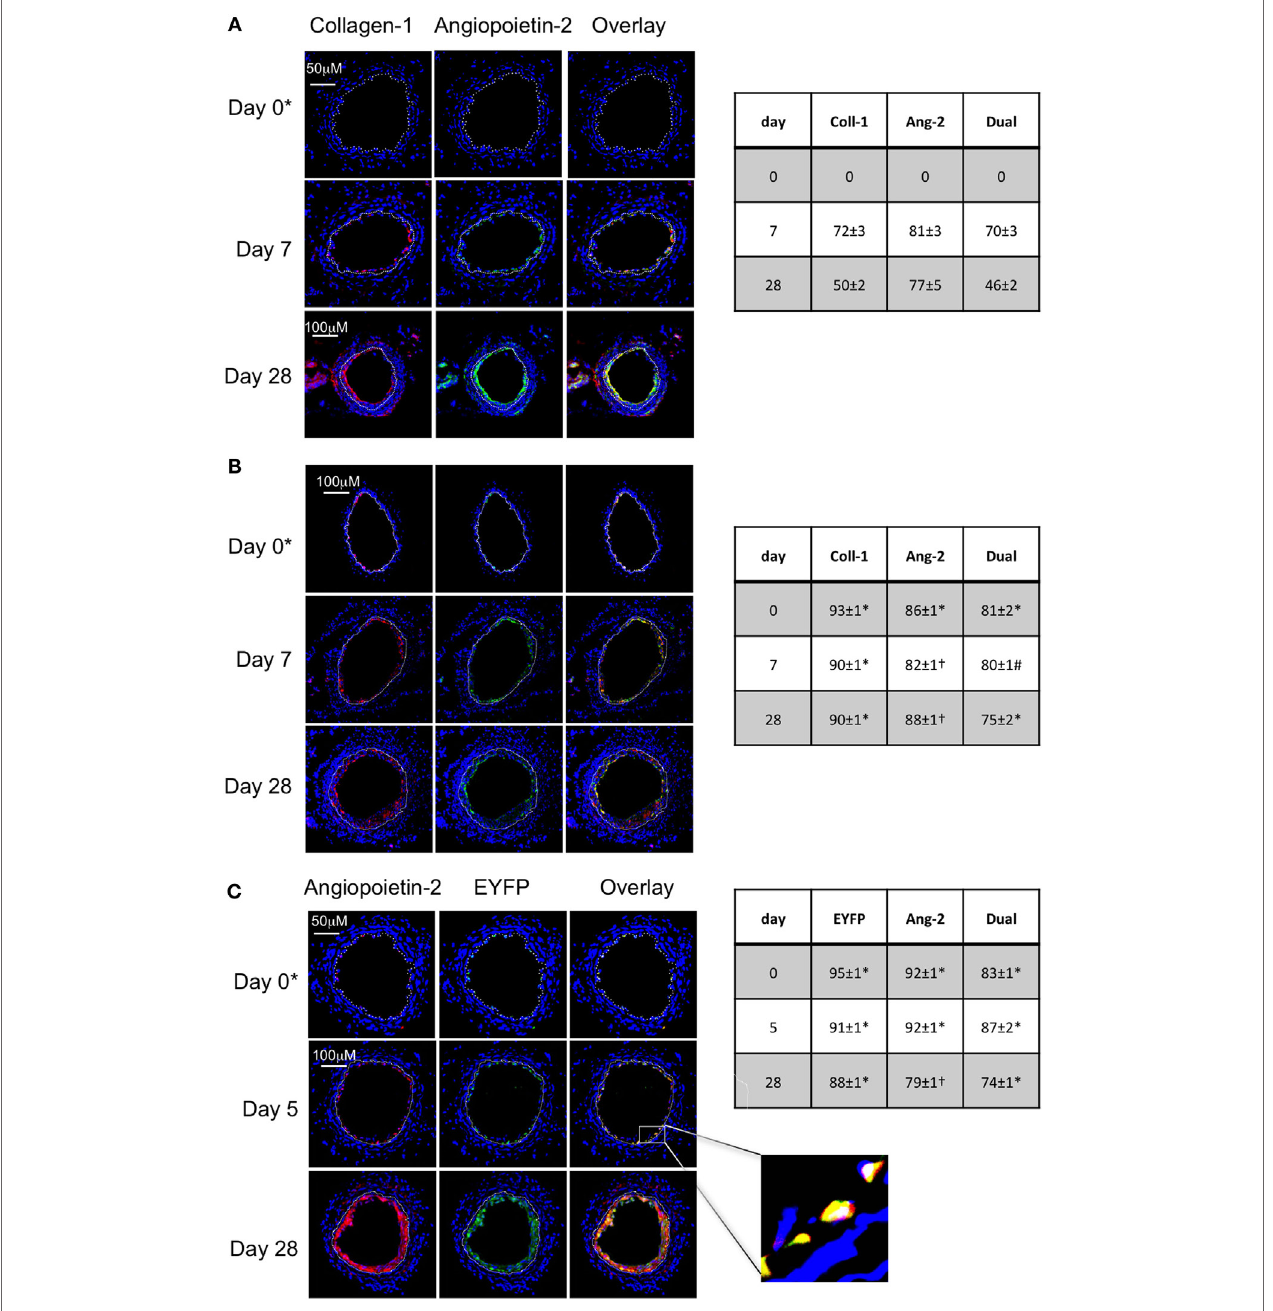
FigUre 1 | Comparison of phenotype of intimal hyperplasia in wild-type (WT) animals vs. WT after adoptive transfer of WT CD34 + cells immediately post-injury. Panels show immunohistology of representative sections through injured mouse carotid arteries harvested on days post-injury as indicated. All sections stained with DAPI (4,6 diamidino-2-phenylindole) nuclear stain (blue) and (red) anti-collagen-1 (a,B) , or angiopoietin-2 (c) , and (green) anti-angiopoietin-2 (a,B) . Yellow indicates co-localization. In (c) , the adoptively transferred cells came from enhanced yellow fluorescent protein (EYFP) mice, which spontaneously fluoresce as shown. The annotated white line defines the junction between neointima and media. (a) Injured mice received no adoptively transferred cells. *On day 0, sections harvested within an hour of injury. (B) Mice injected with cells from WT mice. (c) Mice injected with cells from EYFP mice. Expanded area illustrates that most of the early recruited cells are adoptively transferred, angiopoietin-2 + cells. Tables beside each panel describe summary of staining from all mice ( n = 6), showing the proportion of the neointimal area that is positive for collagen-1, angiopoietin-2 or both or EYFP, angiopoietin-2 or both on days 0, 5/7, and day 28 (% ± SEM). Data derived from three random sections from each of the arteries from each mouse (see Materials and Methods). Subtracting the proportional area occupied by dual positive cells from the total area occupied by angiopoietin-2 + cells suggests the proportional area occupied by collagen-1-negative cells expressing angiopoietin-2. *cf WT (no adoptive transfer) at equivalent time: p < 0.001. † cf WT (no adoptive transfer) at equivalent time, p = NS. # cf WT (no adoptive transfer) at equivalent time p = 0.04. Experiments repeated at least